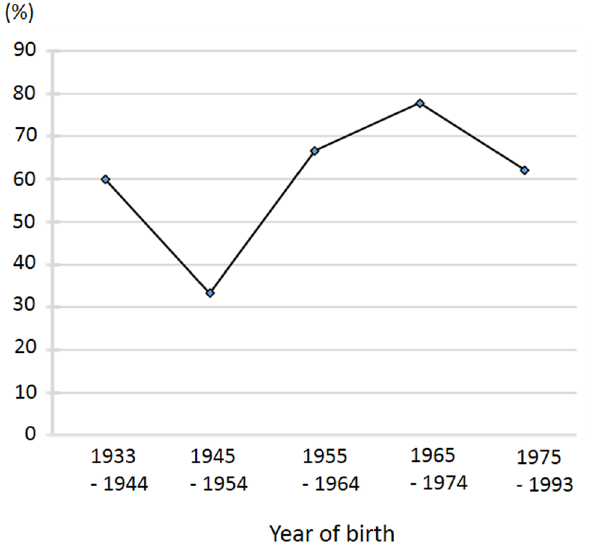
Figure 1. Proportions of patients with CSF IgG abnormality by year of birth. Among the MS patients, the proportion of patients with CSF IgG abnormality did not change significantly with advancing year of birth. CSF, cerebrospinal fluid; MS, multiple sclerosis.